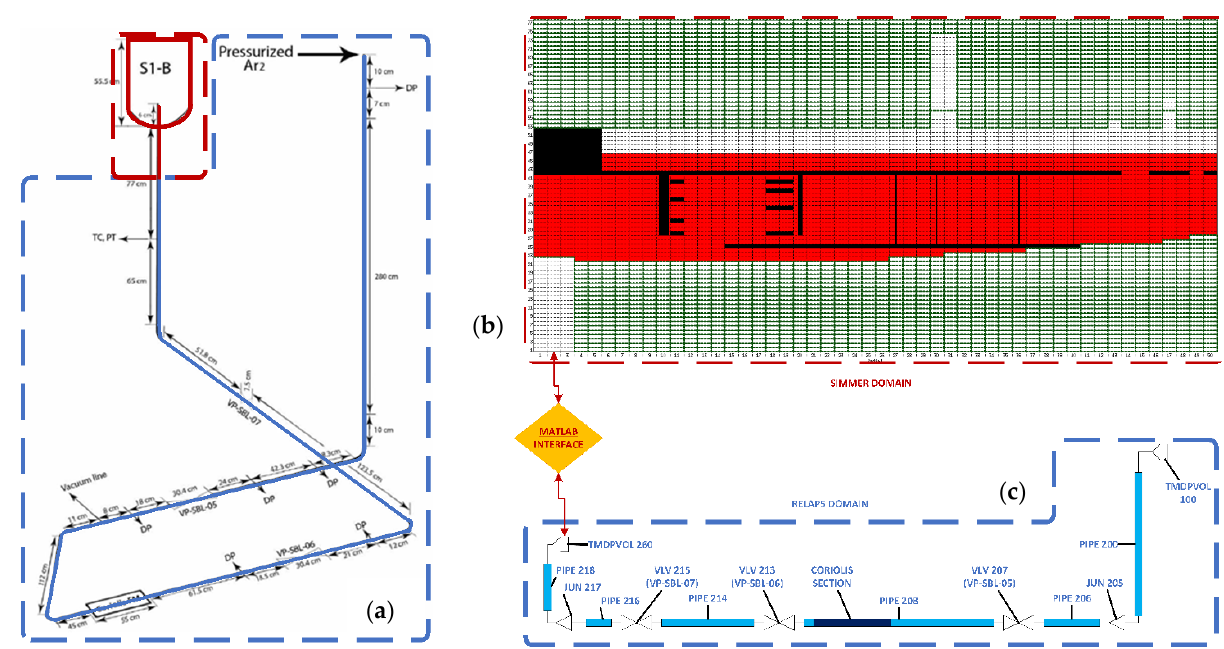
Figure 7. Scheme of coupled codes nodalization. ( a ) LIFUS5/Mod3 facility and coupling tool interface; ( b ) S1B modeled by SIMMER III; and ( c ) injection line modeled by RELAP5/Mod3.3.